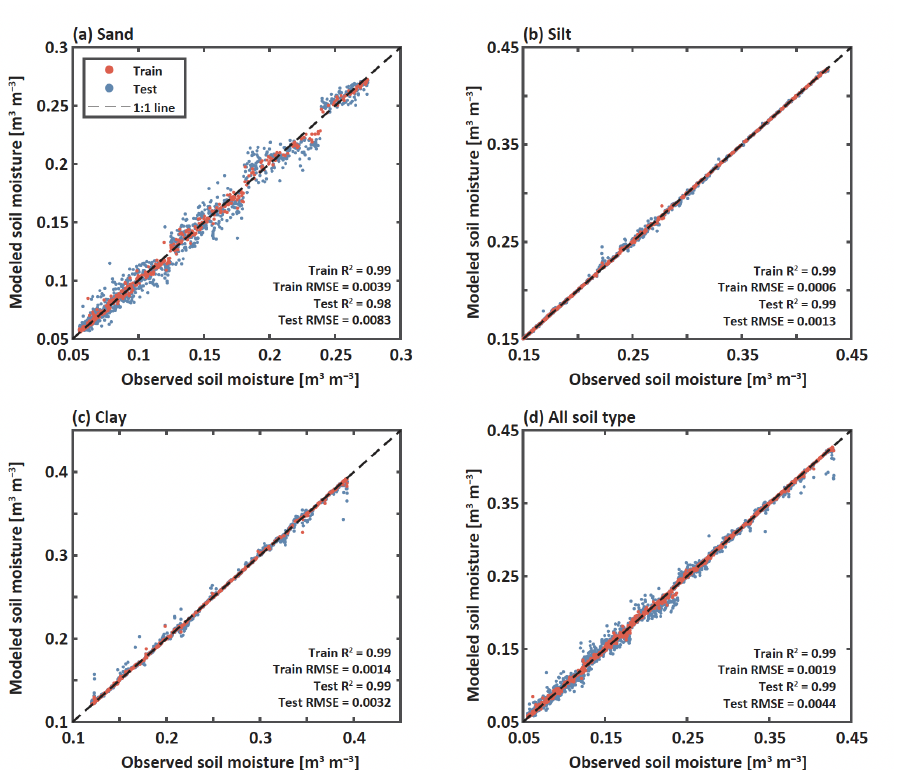
Figure 8. Model validation: 1:1 plot for the observed (x-axis) and predicted soil moisture (y-axis) using random forest for ( a ) sand, ( b ) silt, ( c ) clay, and ( d ) all soil types (a combination of sand, silt, and clay). The red and blue dots represent train and test cases, respectively. The dashed line represents a 1:1 ratio. A machine in the Intelligent Construction System Core-Support Center of Korea Basic Science Institute Center was partially used in this